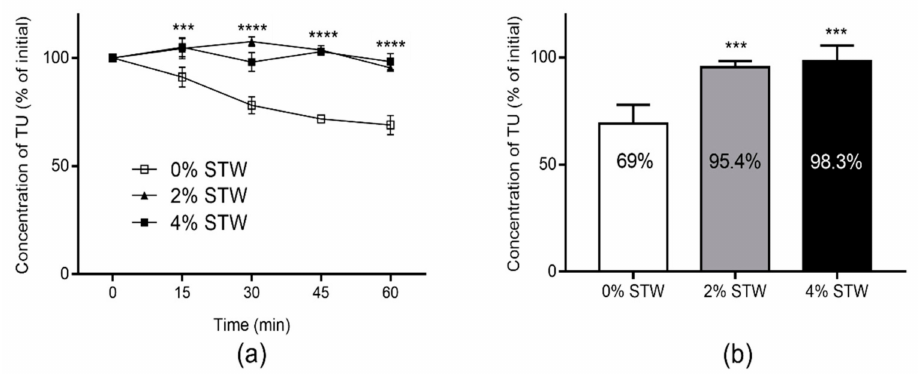
Figure 3. ( a ) The hydrolysis of testosterone undecanoate (TU) in Caco-2 cell homogenates in the presence of 0%, 2%, and 4% strawberry (STW) extract; ( b ) The unhydrolyzed fraction of TU dose following 60 min incubation. Values are expressed as percentage of TU concentration at time 0 (mean ± SD, n = 4). Statistical analysis was performed using one-way and two-way ANOVA with Dunnett’s multiple comparisons test, as appropriate. Statistical differences of 2% and 4% STW groups were similar when compared to STW-free Caco-2 cell homogenate group; *** p < 0.001; **** p <